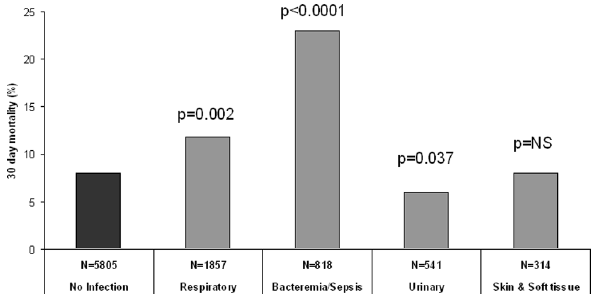
Figure 1. 30-day mortality rates per infection type. Thirty-day mortality was compared between each of the HF patient cohorts admitted with distinct infections and HF patients admitted for non- infectious causes. HF patients admitted with respiratory infections, bacteremia or sepsis had significantly higher mortality rates, while HF patients admitted with skin and urinary tract infections had similar and lower 30-day mortality rates, respectively.